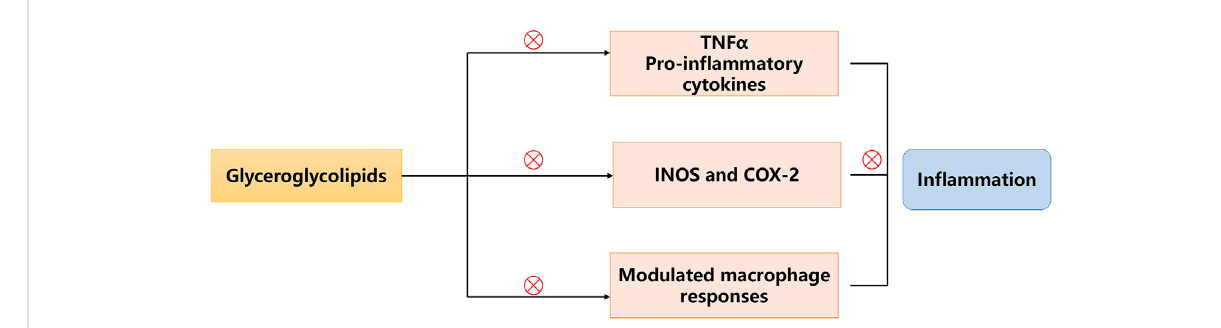
FIGURE 3 Anti-in fl ammatory mechanism of glyceroglycolipids.